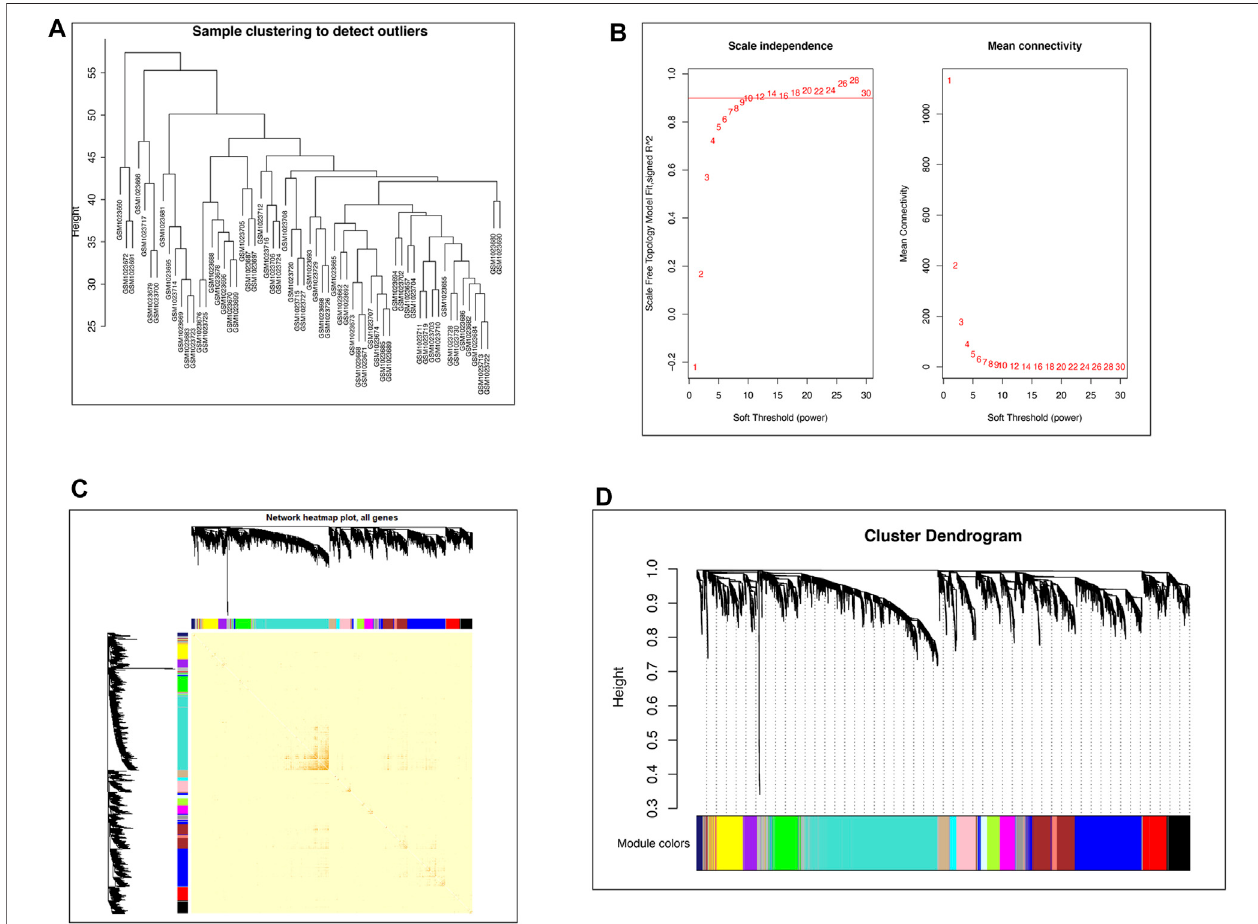
FIGURE 1 | WGCNA network construction. (A) Clustering dendrogram of 63 samples to detect outliers. (B) Network topology analysis under different soft thresholds. Left: Impact of the soft-threshold power on the scale-free topology fi t index. Right: Analysis of the mean connectivity for various soft-threshold powers. The power selectedwas12. (C) Visualized genenetworkoftheheatmapplot. Adarkerred colorindicates greateroverlap, and alightcolorindicates lowoverlap. Theblocks of darker color along the diagonal are the gene modules. The module assignment gene and dendrograms are on the top and left, respectively. (D) Gene clustering dendrogram obtained by hierarchical clustering on the basis of adjacency-based dissimilarity.